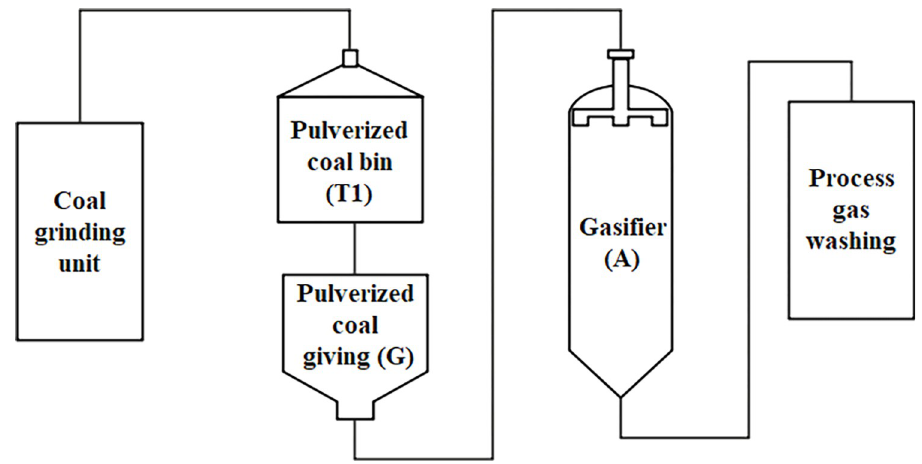
Fig 1. Overview of the coal gasification process.